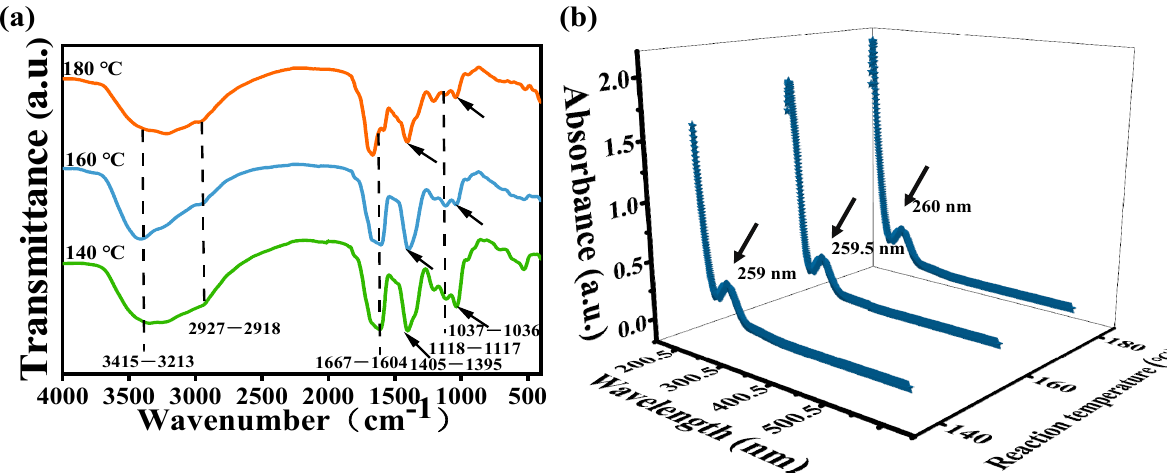
Figure 2. ( a ) FT-IR spectra; ( b ) UV–vis absorption spectra of mussels-derived CDs prepared at dif- ferent reaction temperatures.